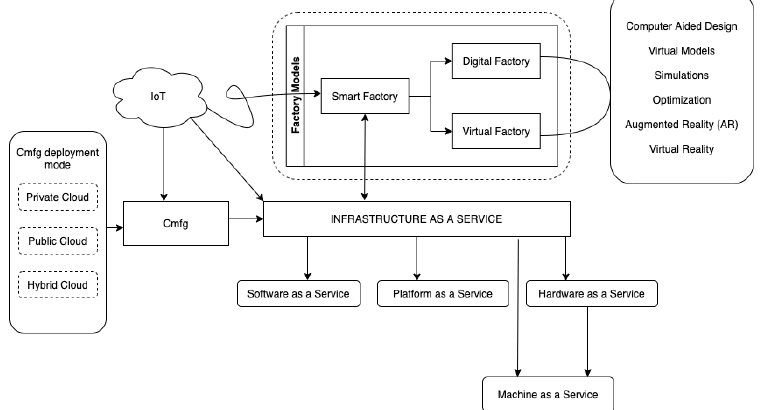
Figure 8. Factory of Future building